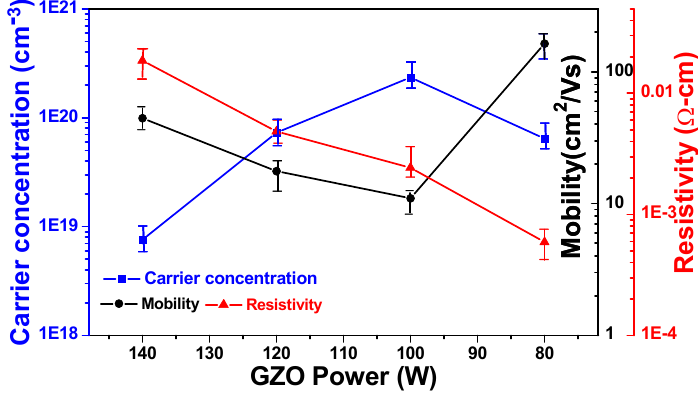
Figure 8. Hall mobility, carrier concentration, and resistivity of IGZO thin films as a function of deposition power of GZO ceramic